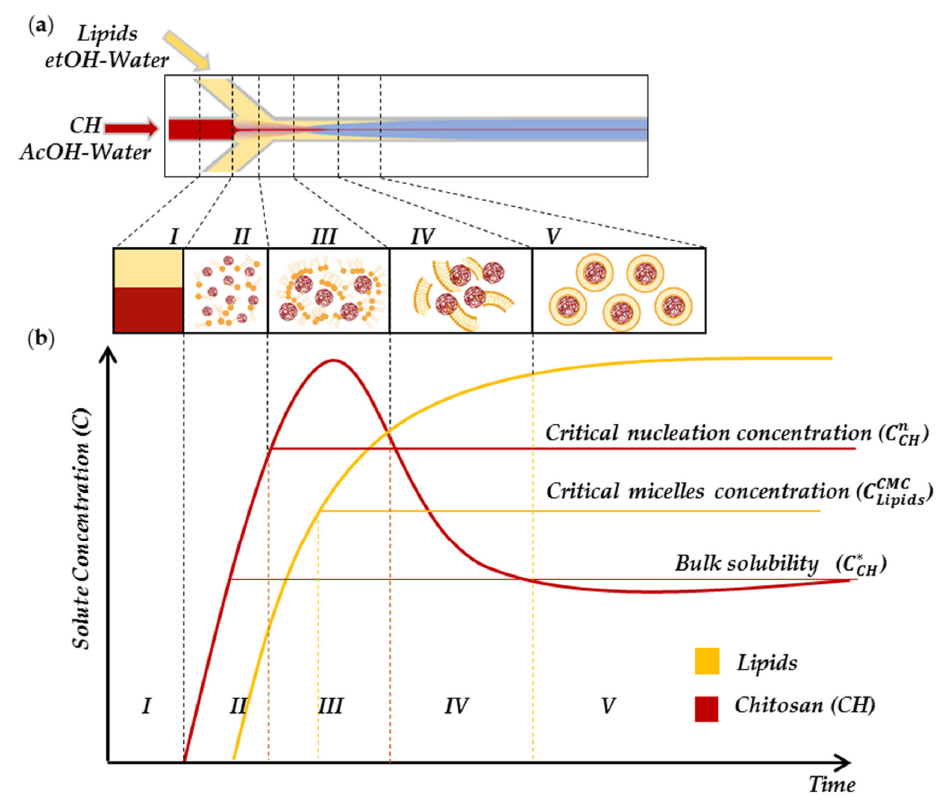
Figure 2. Schematic illustration of nanoprecipitation and self ‐ assembly processes implemented in microfluidics. ( a ) Sketch of coupled Hydrodynamic Flow Focusing (cHFF), implemented by injecting Lipids dissolved in Ethanol/Water (etOH/Water, yellow stream) and Chitosan in Acetic Acid/Water (AcOH/Water, red stream) for Lipid–Polymer Nanoparticles’ (LiPoNs) production (blue stream). ( b ) Schematic diagram of LiPoNs forming process in the cHFF: (I) Chitosan and Lipids dissolved in solvent mixture injected into the microfluidic channels; (II) Chitosan supersaturation and Lipid monomers formation; (III) Chitosan Nuclei and Lipid micellization; (IV) Chitosan intermediate and bilayer fragments formation; (V) Lipid–chitosan nanocomplex